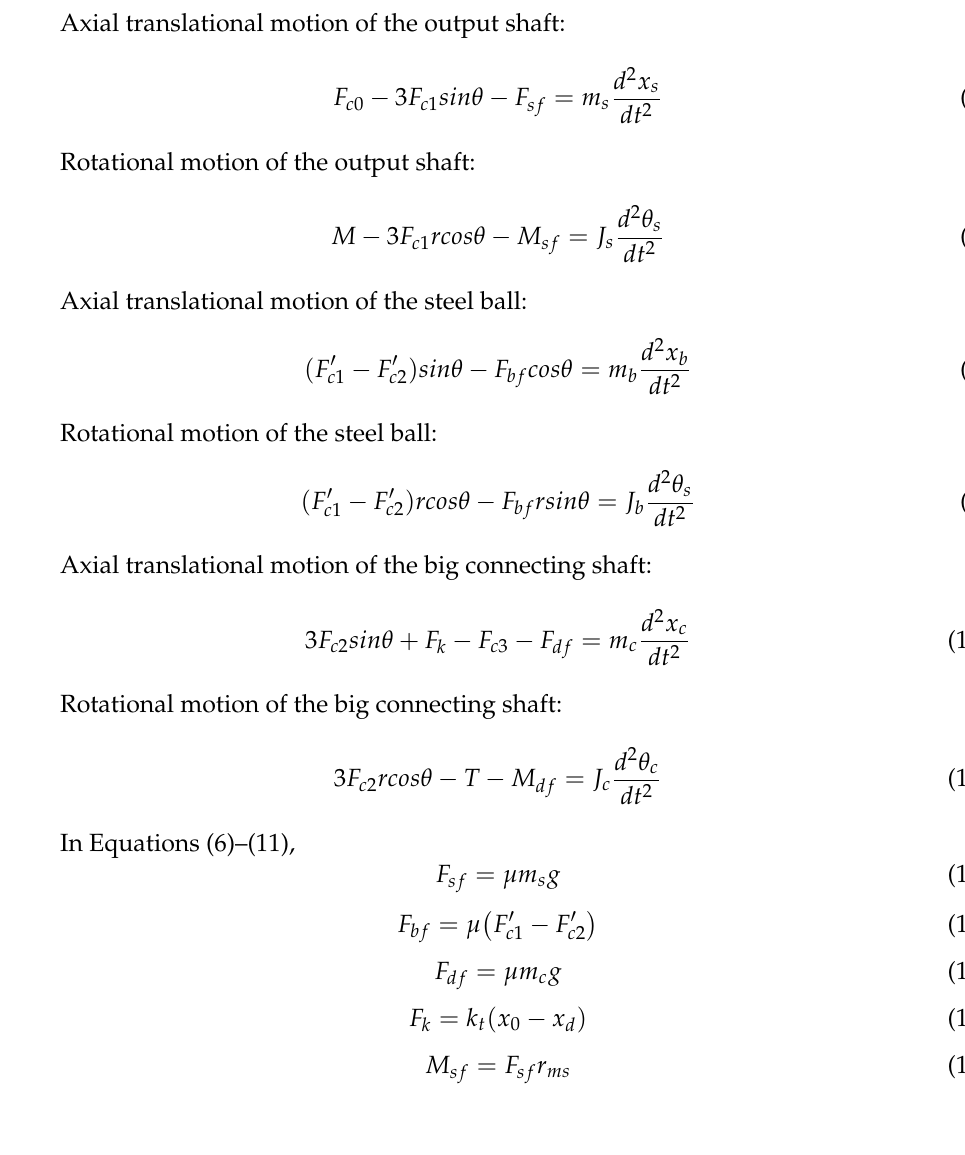
Figure 4. Schematic diagram of force and torque on the big connecting shaft during braking.